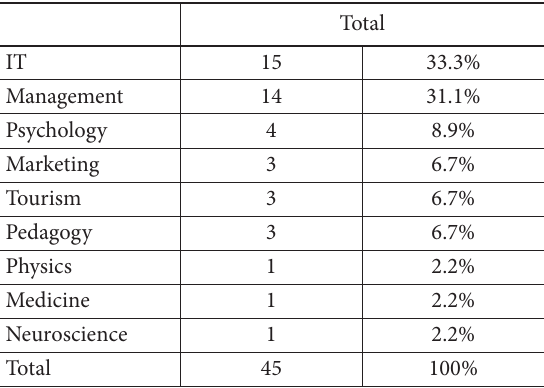
Table 4. Major study disciplines (source: authors,